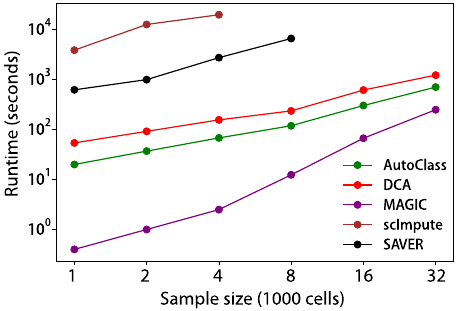
Fig. 7 Sample size vs runtime for different denoising